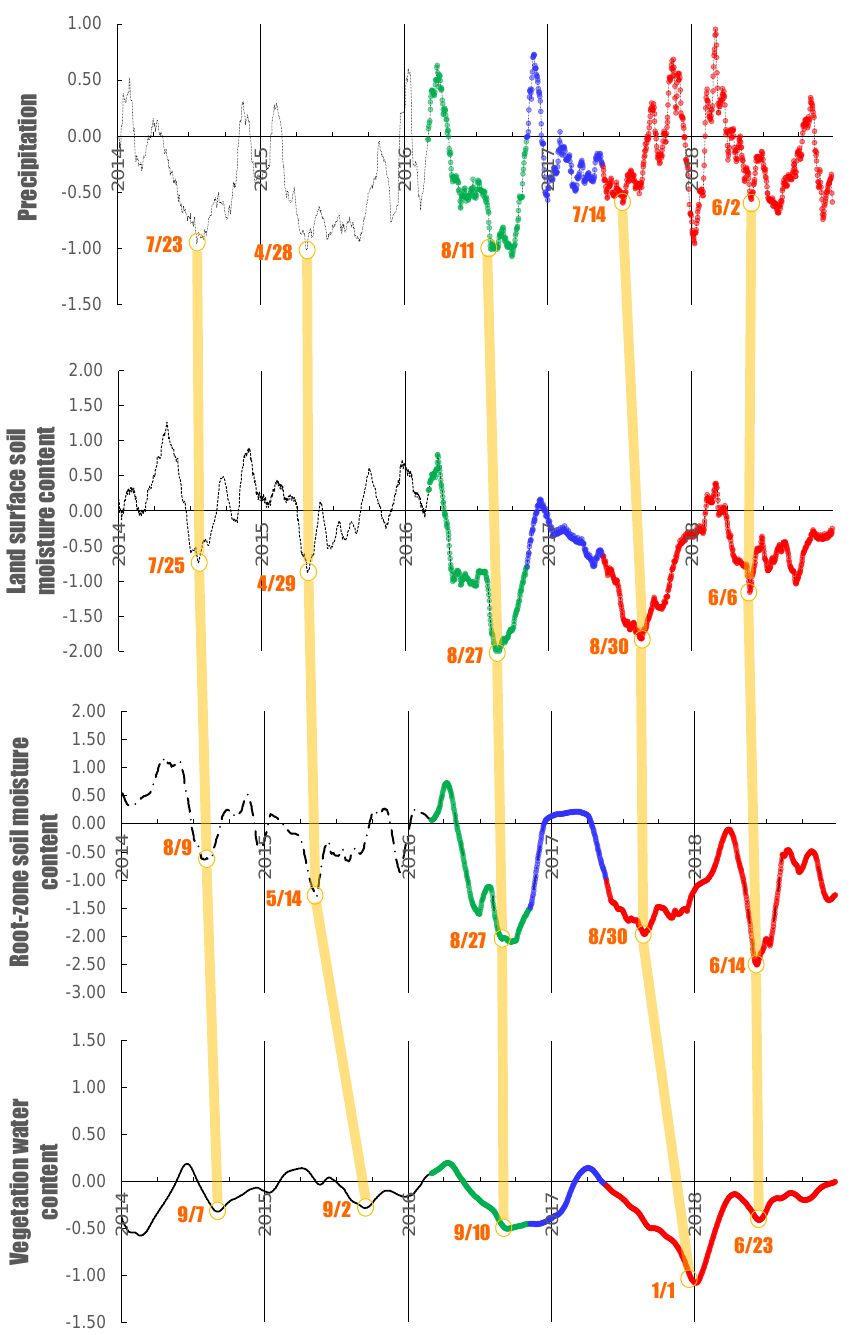
Figure 9. Normalized index ( NI i ) for precipitation and ecohydrological variables in the second half of the agricultural drought evaluation period (2014–2018). Spatial averages for the Sahel-inland region. From the top, the graphs present precipitation, near-surface soil moisture content, root-zone soil moisture content, and vegetation water content. Dates in orange indicate the middle day of each negative peak period. We found that each peak had a time lag when focusing on the negative peak for precipitation, soil moisture content, and vegetation water content, as shown by the yellow marks and lines. As shown by the green lines, although the NI i values of precipitation become positive in April 2016, negative values remain in the growth and early harvest seasons (May–October), which leads to negative NI i values of soil moisture and vegetation water content simultaneously. As shown by the blue lines, although the NI i values of precipitation became positive in the second half of December 2016 owing to the occurrence of heavy rainfall, they reverted to negative values in the beginning of January 2017. The surface soil moisture content showed the same behavior. In